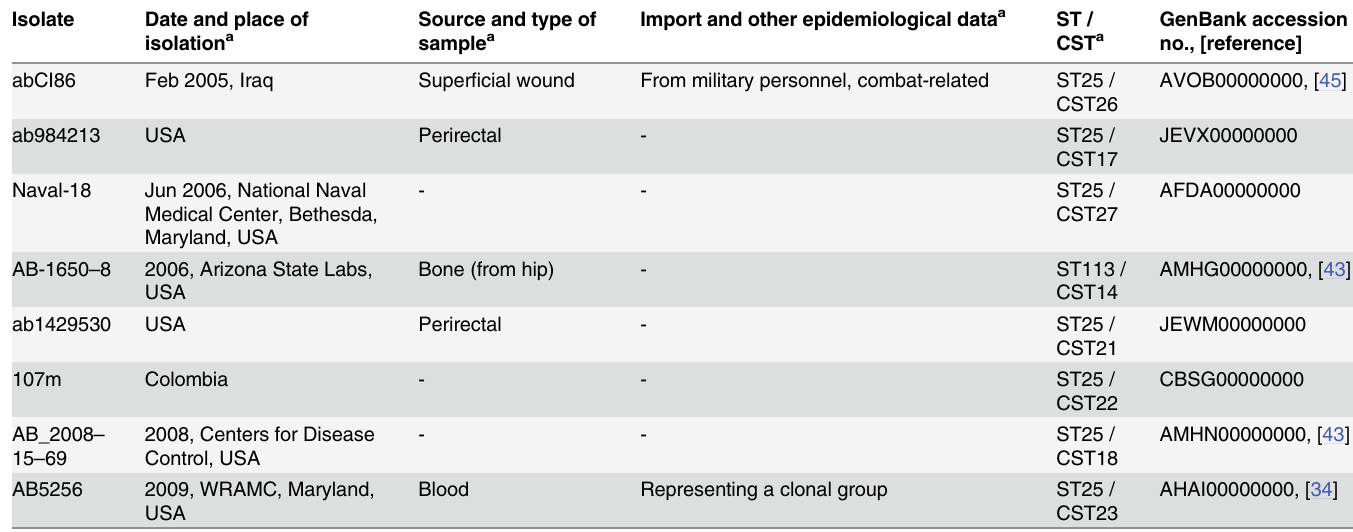
(iii) 1251 bp of the csy1 (Cas system-associated) gene, (iv) 615 bp of the csy4 gene, and (v) 2976 bp of the concatenated MLST sequences. Only isolates with sequenced genomes were included in the phylogenetic analyses. The online available package of programs (MUSCLE, Gblocks, PhyML, and TreeDyn) was used for nucleotide alignment, tree construction, and tree rendering [26]. One hundred bootstraps were used for bootstrap analysis.